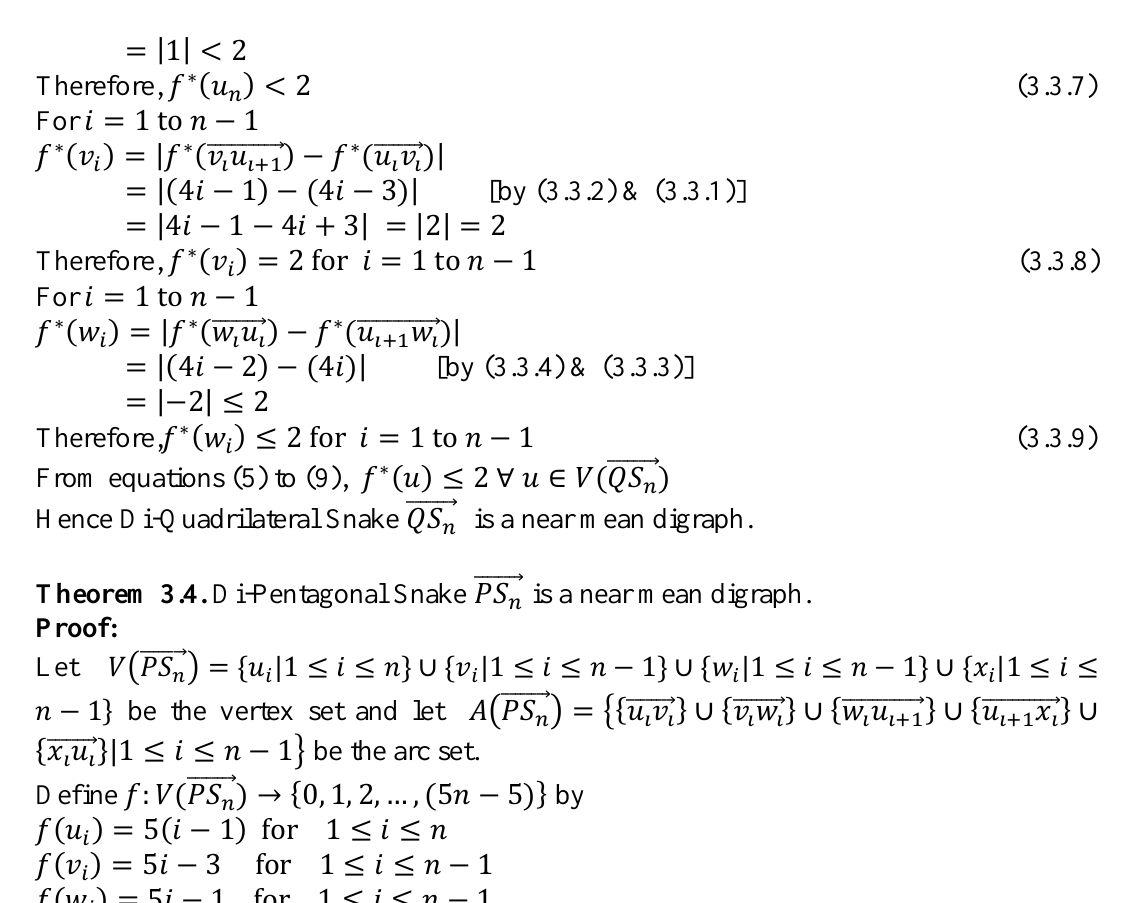
Figure 3.2. The labeling of a Di-Pentagonal